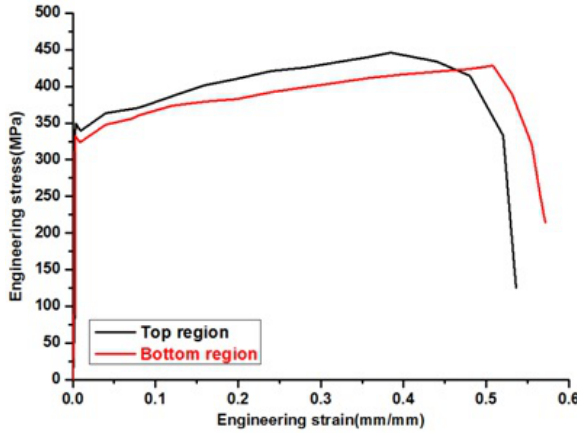
Figure 7: Stress–strain curves of the tensile